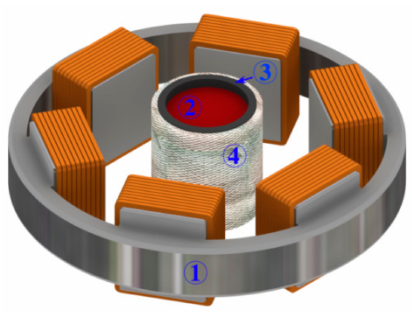
Figure 1. Schematic diagram of the experimental device: ( 1 ) electromagnetic coil, ( 2 ) Al-30Si melt, ( 3 ) graphite crucible, ( 4 ) thermal insulation material.